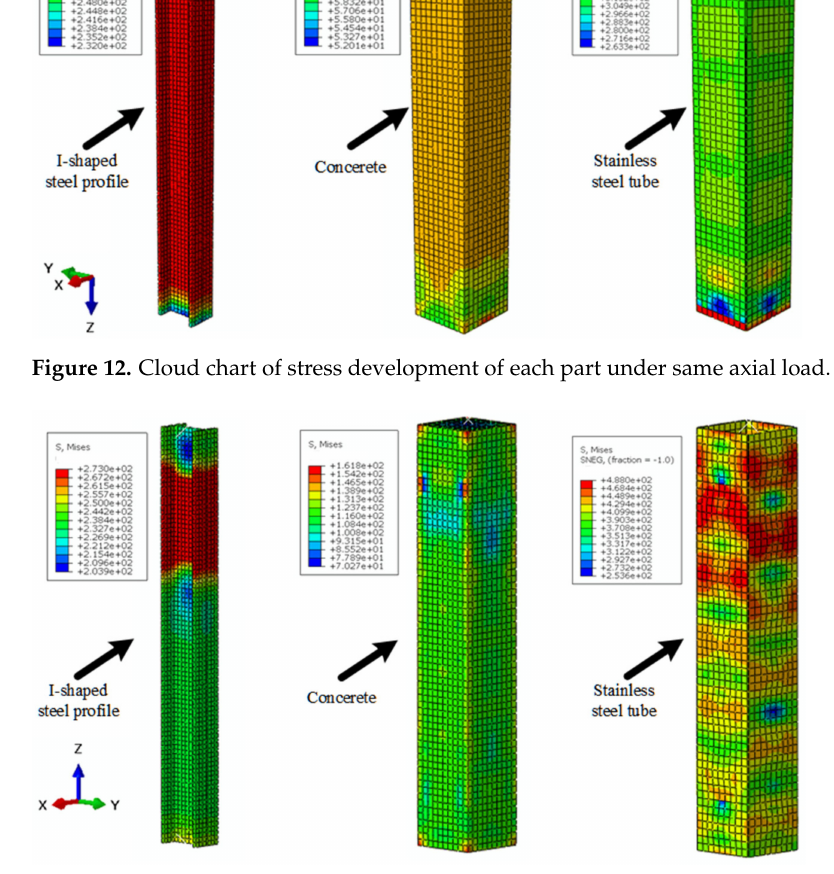
Figure 13. Stress nephogram of all parts when stainless-steel pipe bulges and